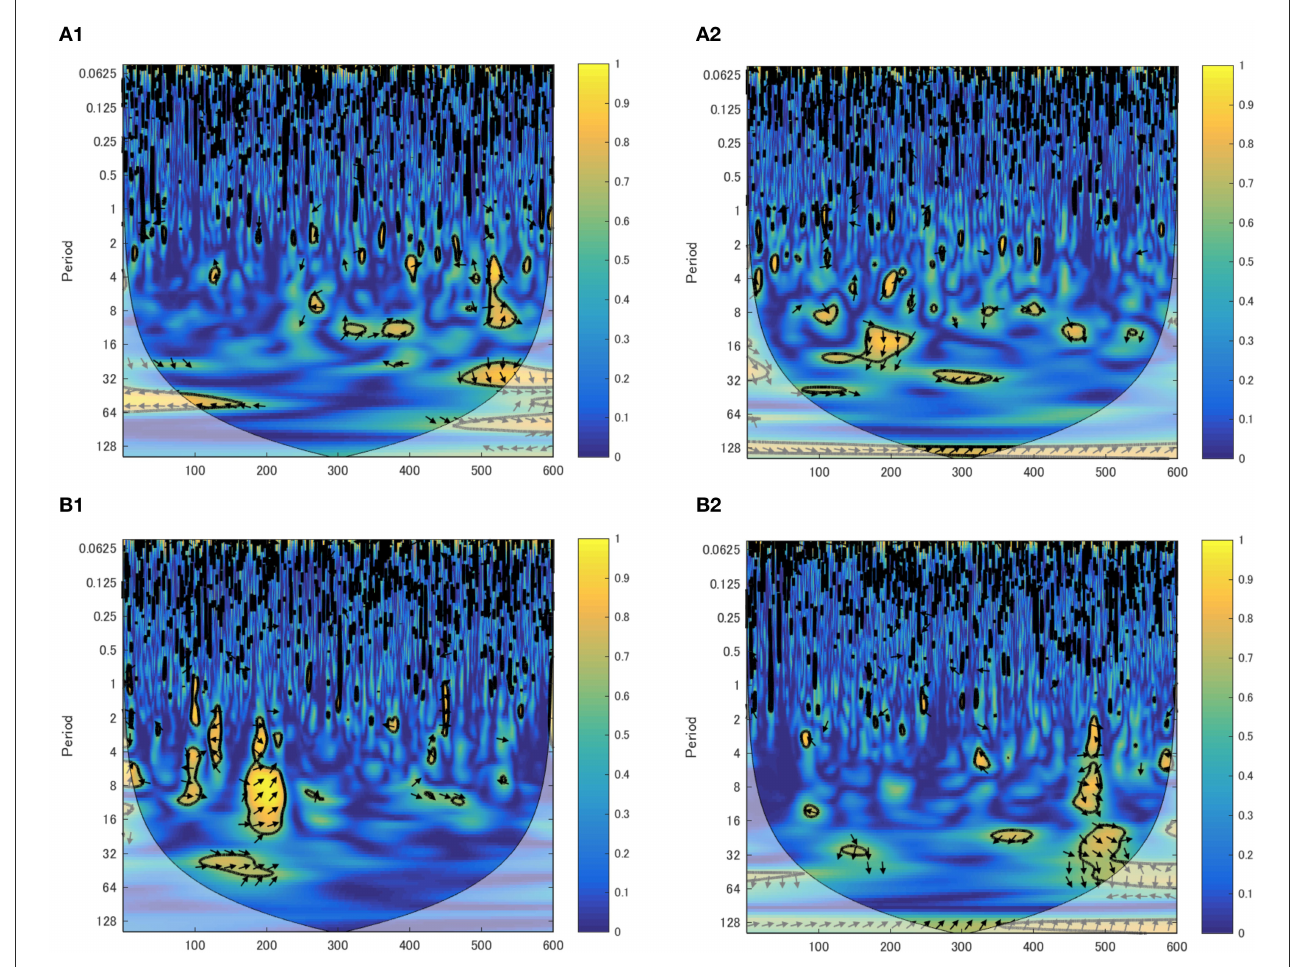
FIGURE1 Cross-wavelet coherence planes of an example dyad with a truth-teller on (A1) climate change and (A2) tuition increases and a deceiver on (B1) climate change and (B2) tuition increases. In each plane, the x -axis represents time. The left half of each x -axis indicates the first half of the 10-min conversation. The right half of each x -axis indicates the second half of the 10-min conversation. The y -axis represents each frequency component, as an inverted period (e.g., 0.25 period is 4Hz), in plane. The magnitude of coherence is represented by color. The color yellow indicates more synchrony than the color blue. The cone of influence (COI) area that is shown as a lighter shade is not included in the analysis since the calculation of coherence can be biased by the edge effect. As the left half of Figure 1 illustrates, a dyad with a truth-teller discussing climate change demonstrated stronger increases in synchrony during the second half of the conversation (top left image) compared to a dyad with a deceiver discussing climate change (bottom left image). Additionally, as the bottom of Figure 1 illustrates, a dyad with a deceiver demonstrates stronger increases in synchrony during the second half of the conversation if they talked about tuition increases (bottom right image) compared to if they talked about climate change (bottom left image).